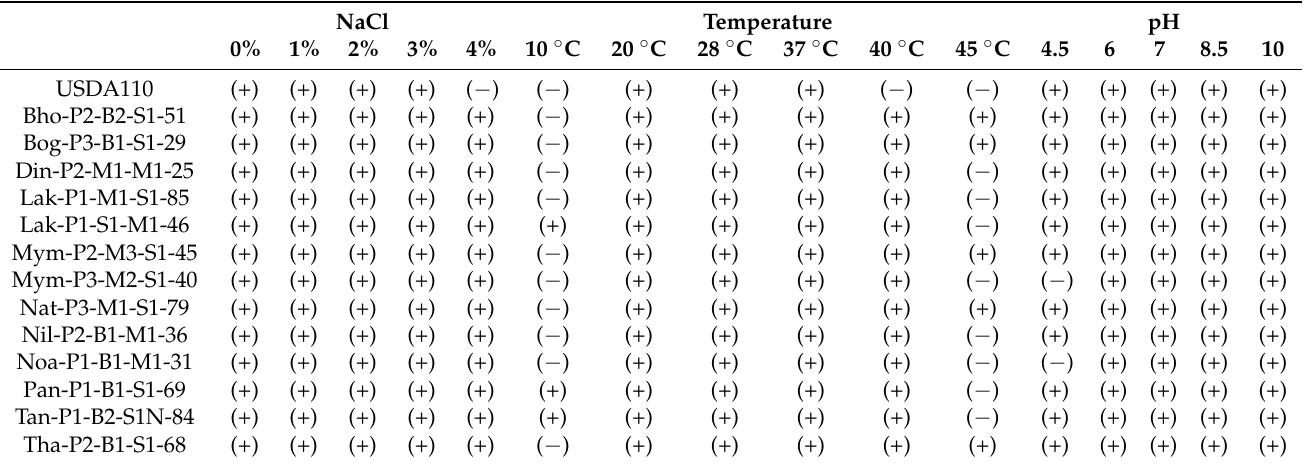
Table 4. Data of stress-tolerance tests of selected isolates. NaCl Temperature